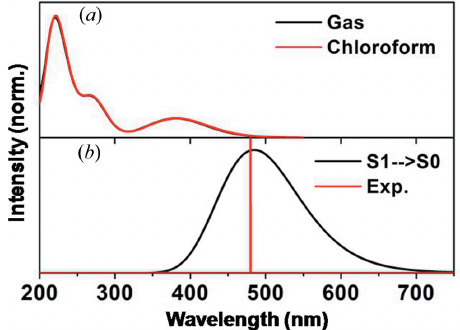
Figure 5 ( a ) Calculated absorption spectra of t -C 5 -PyDI in gas and in chloroform. ( b ) Calculated fluorescence spectra of t -C 5 -PyDI in cyclohexane.